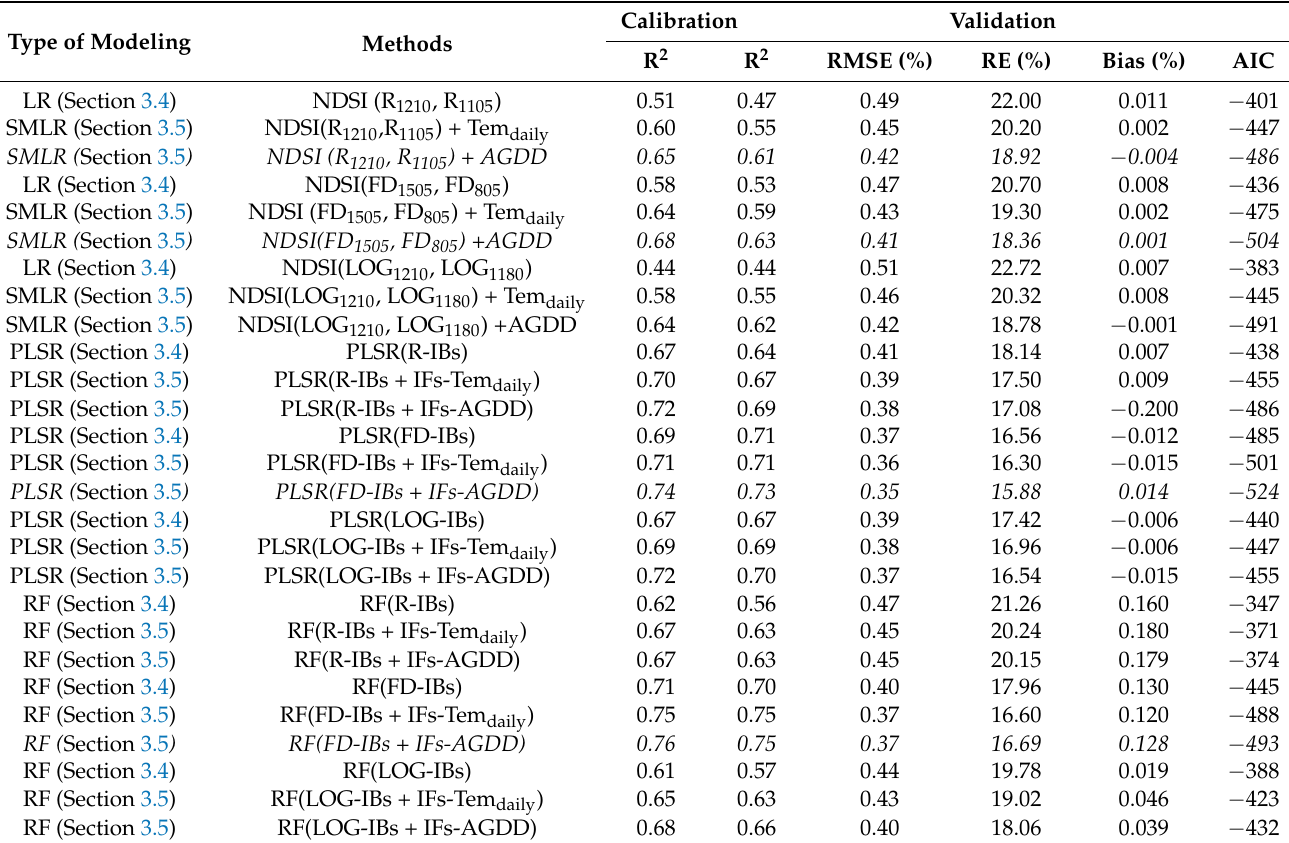
Table 7. Relationships of plant potassium content (PKC) and various